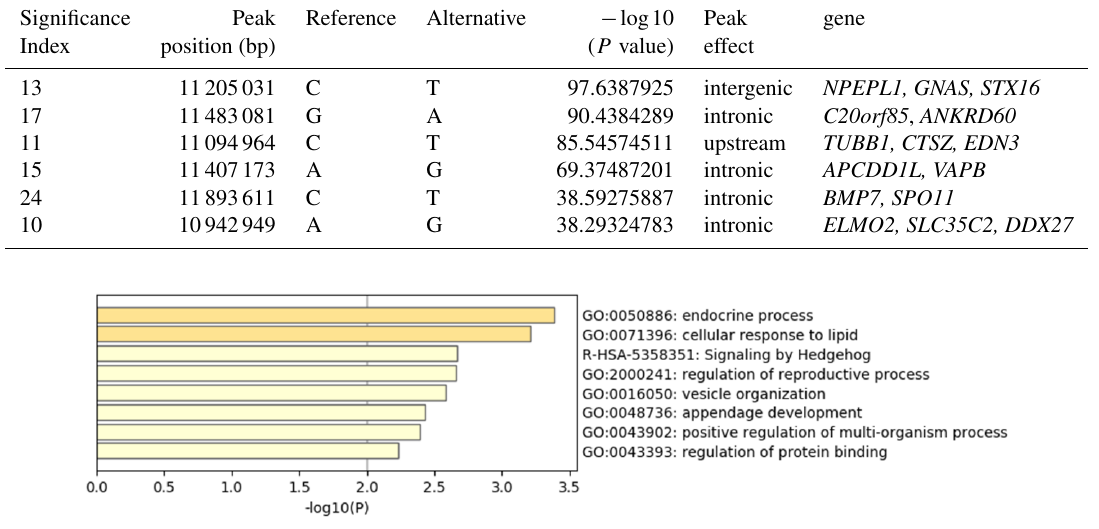
Figure 5. Enriched ontology clusters.